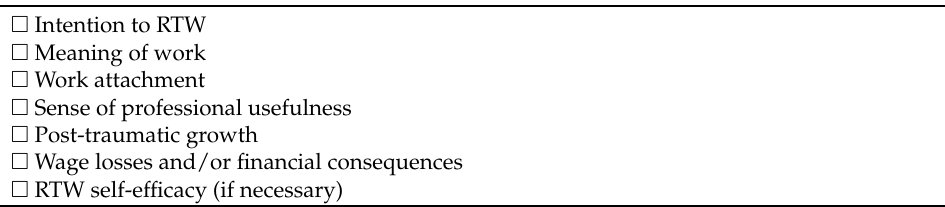
Table 3. Discussion points for value